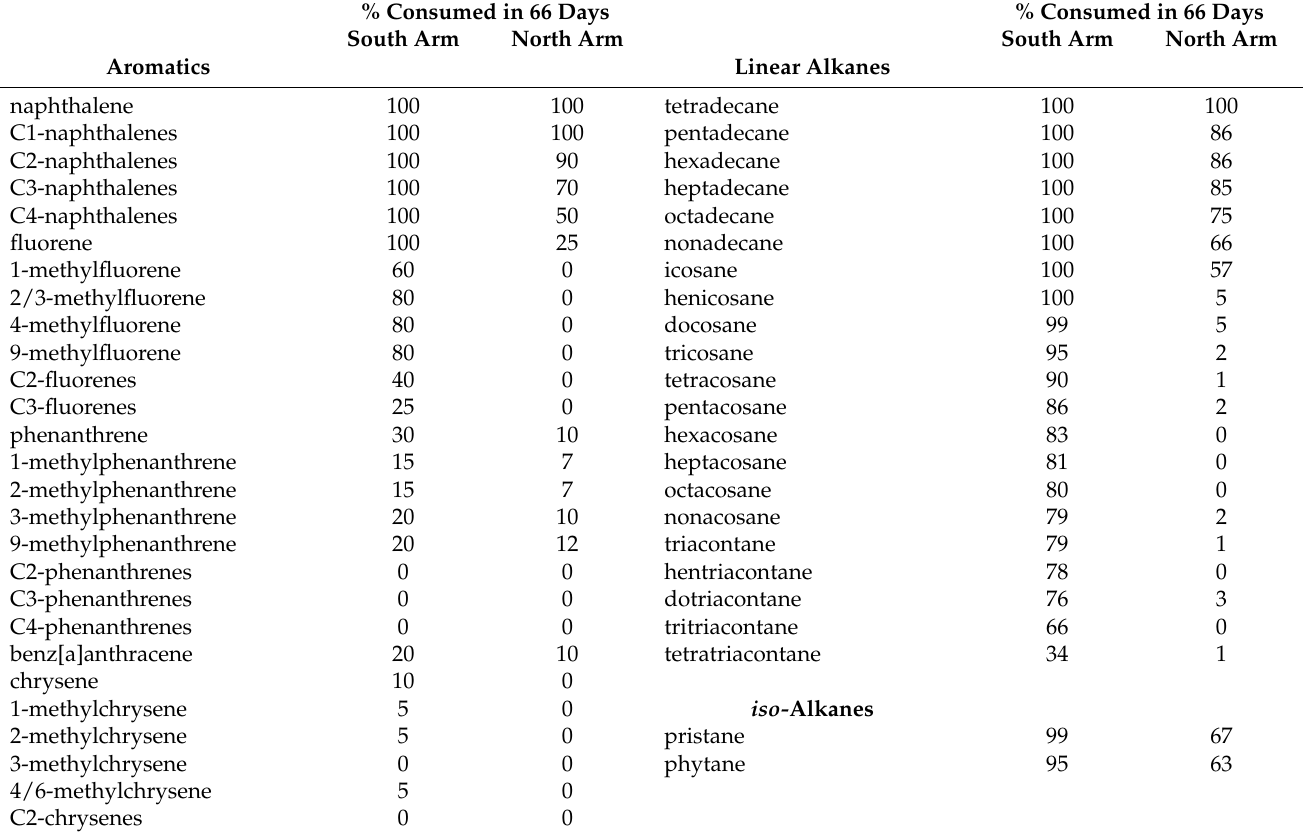
Table 2. The biodegradation of crude oil hydrocarbons in 66